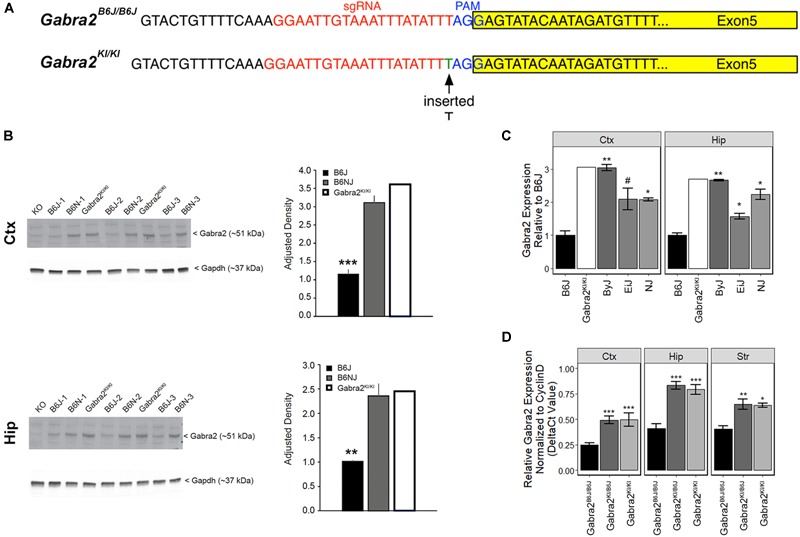
Repair of the private deletion in B6J is sufficient to restore GABRA2 protein and mRNA levels. (A) Site of repair of the private deletion in B6J (green), guide RNA (red) and PAM site (blue) are shown. The exon is highlighted in yellow. (B) Protein levels of GABRA2 are also restored in the hippocampus (top panel) and cortex (bottom panel) of the original Gabra2KI/KI founder mouse (n = 1) relative to B6J (n = 3) and are similar to that of B6NJ (n = 3). Western blot shown to the left and adjusted density bar graph shown to the right for each region. (C) Hippocampal and cortical Gabra2 mRNA levels were restored in the original Gabra2KI/KI founder after insertion of a single nucleotide relative to B6J. Expression of Gabra2 in the founder mouse was similar to that of other B6 substrains. Expression was measured via qPCR and shown relative to B6J. Males and females were combined for the statistical analysis (n = 5 to 6 per strain). Note that CRISPR founders can often be mosaic for the introduced mutation such that some cells may have the mutation, some may not, and other cells may have different mutations. We include molecular validation in the founder in order to demonstrate that our engineering approach worked, and that mosaicism is not evident in brain tissue of the Gabra2KI/KI founder mouse. Tissue from Gabra2 knockout mice (KO, predominately B6J background mixed with 129/SvEv, see section Materials and Methods) was kindly provided by Y. Blednov from The University of Texas and used as a negative control. (D) Hippocampal, striatal, and cortical Gabra2 mRNA levels were also restored in heterozygous Gabra2KI/- and homozygous knockin Gabra2KI/KI mice after insertion of a single nucleotide relative to homozygous Gabra2B6J/B6J mice. Expression measured via qPCR and data were analyzed at the ΔCt level (relative to the expression of the control gene Cyclin D). There is a significant main effect of genotype [F(2,32) = 47.1, p = 2.9e-10] and brain region [F(2,32) = 27.89, p = 9.7e-08]. The interaction was not significant. Pairwise significance between genotypes and within brain region were determined using Tukey’s HSD test. Significance defined as: #p < 0.1, ∗p < 0.05, ∗∗p < 0.01, ∗∗∗p < 0.001.